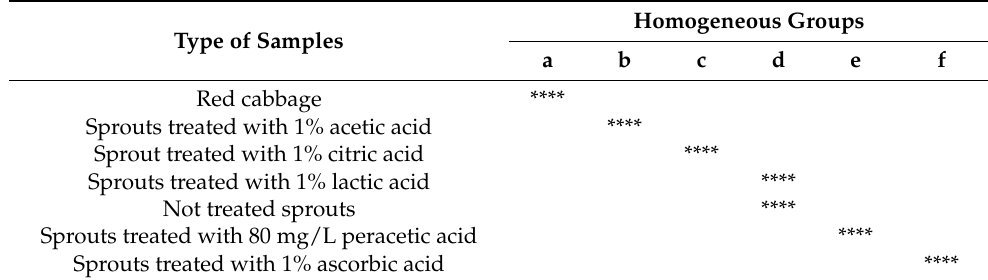
Figure 3. Antioxidant properties (ABTS) of red cabbage sprouts with the addition of solutions of various organic acids subjected to 7- and 14-day storage. The graph shows the mean values and standard deviation ( n = 3). Table 1. Group homogeneity test ( α = 0.05) comparing the effect of applied organic acids on the content of polyphenols (TPC) in red cabbage sprouts not subjected to storage.